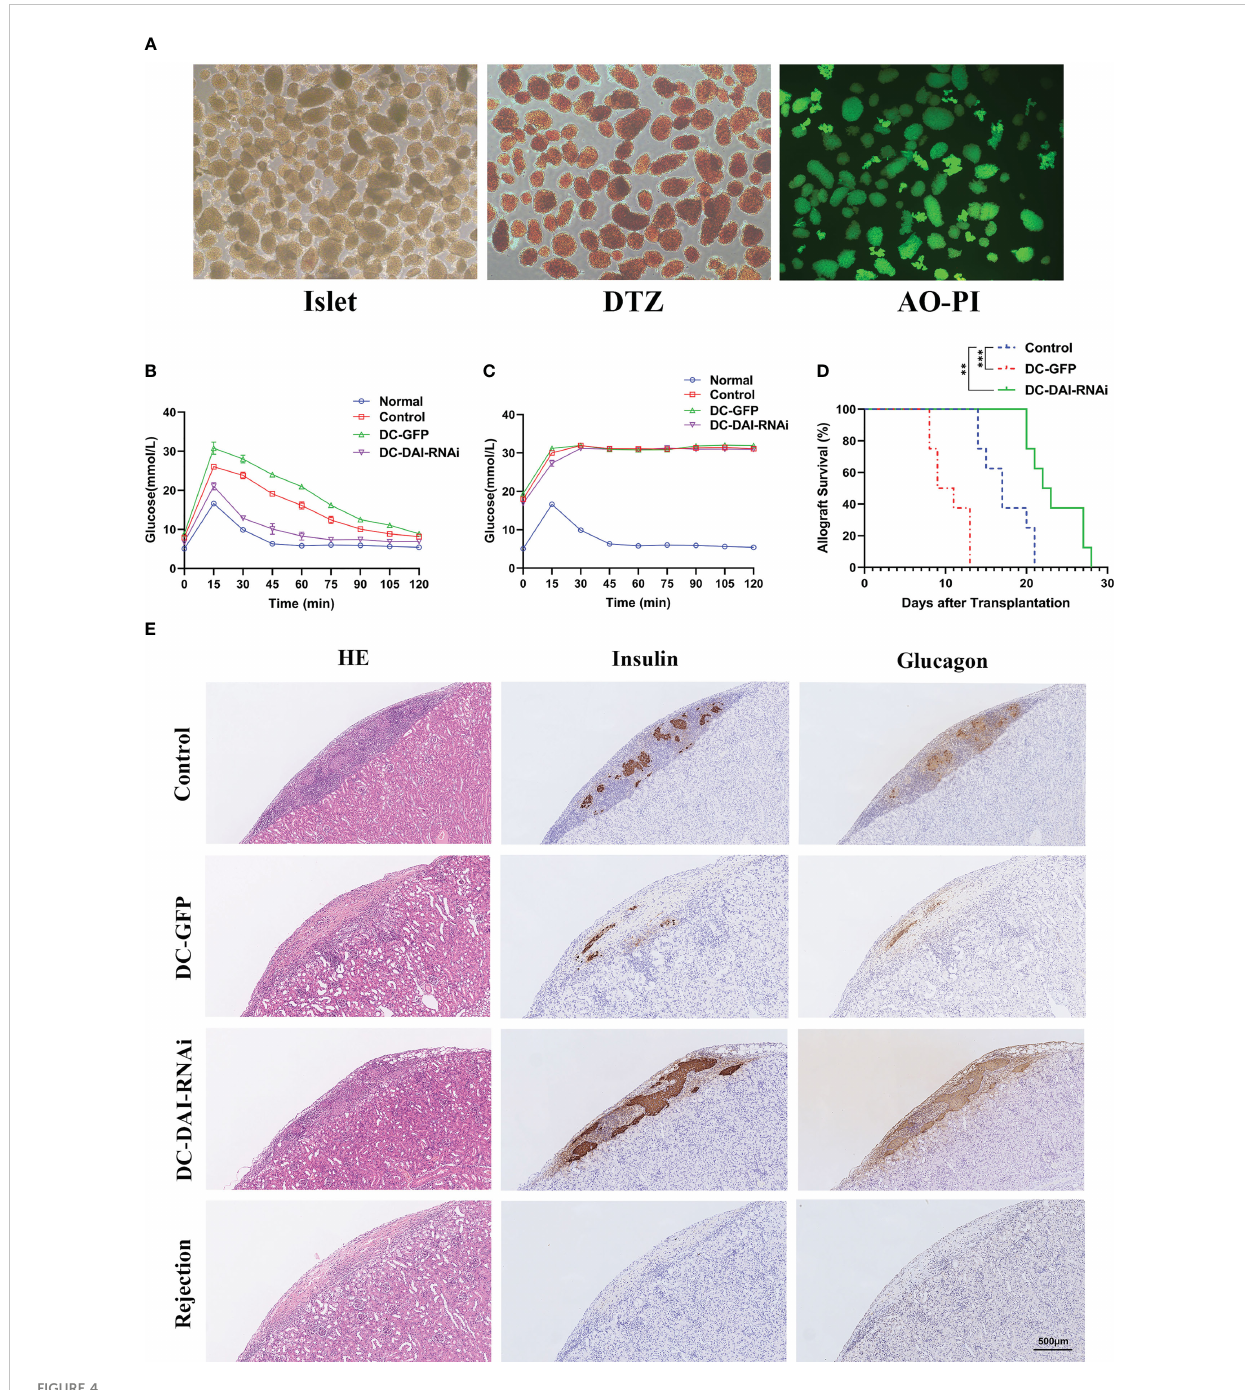
FIGURE 4 DCs transduced with AdV-DAI-RNAi-GFP prolonged islet allograft survival. (A) Islets isolated from perfusion, digestion, and puri fi cation procedures with suf fi cient purity (DTZ, ×40) and activity (AO-PI, ×40). (B) Intraperitoneal glucose tolerance tests (IPGTTs) were performed on postoperative day (POD) 10 to test recipient glucose tolerance after 4 – 6 h of fasting (n=5). (C) IPGTTs were repeated after the removal of the islet-bearing kidney to con fi rm that the recipient blood glucose response was dependent on the islet allograft (The upper limit of the blood glucose meter is 33.3 mmol/L, and if the blood glucose level was above the limit, it was recorded as 33.3 mmol/L. Data were expressed as means only, n=5). (D) Survival curves of islet allografts in the PBS control, DC-GFP, and DC-DAI-RNAi groups. Allograft survival among groups was compared with Kaplan – Meier analysis (**P < 0.01, ***P < 0.001, n=8). (E) On POD 11, islet-bearing kidneys in each group were removed and stained with the indicated markers. DC-DAI- RNAi-treated recipients displayed less lymphocyte in fi ltration and higher insulin and glucagon expression than the other groups, indicating greater function and better survival of islet allografts (× 200,